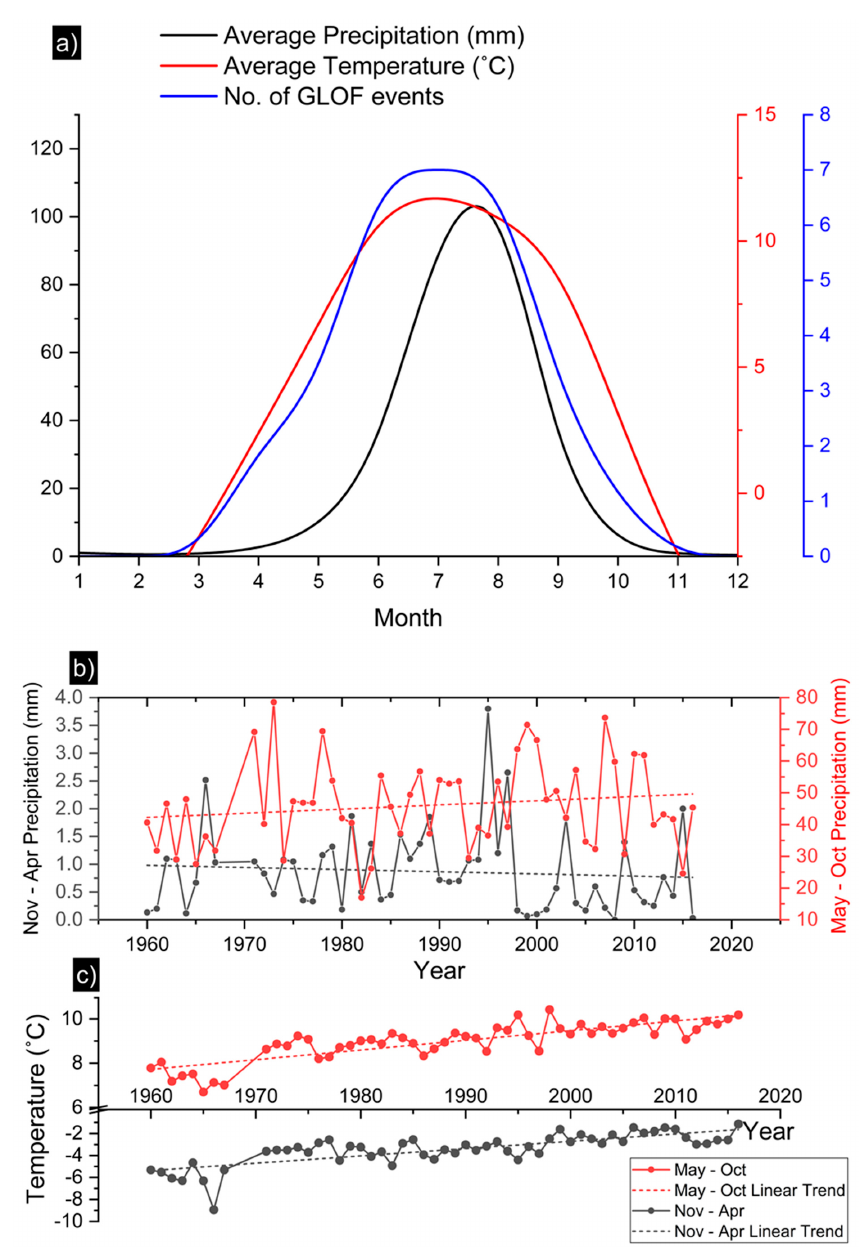
Figure 8. ( a ) Correlation among precipitation, temperature, and GLOF events during 1935–2017. ( b ) Seasonal annual average variation in precipitation during 1960–2017. ( c ) Seasonal annual average variation in temperature during 1960–2017.